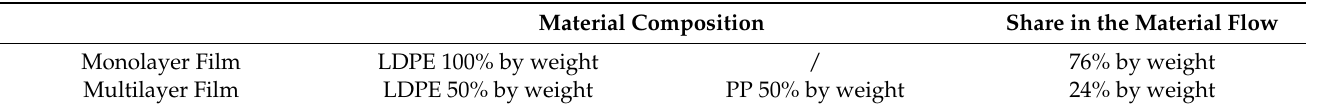
Table 2. Material composition of the plastic films under consideration and their share in the material flow [4].